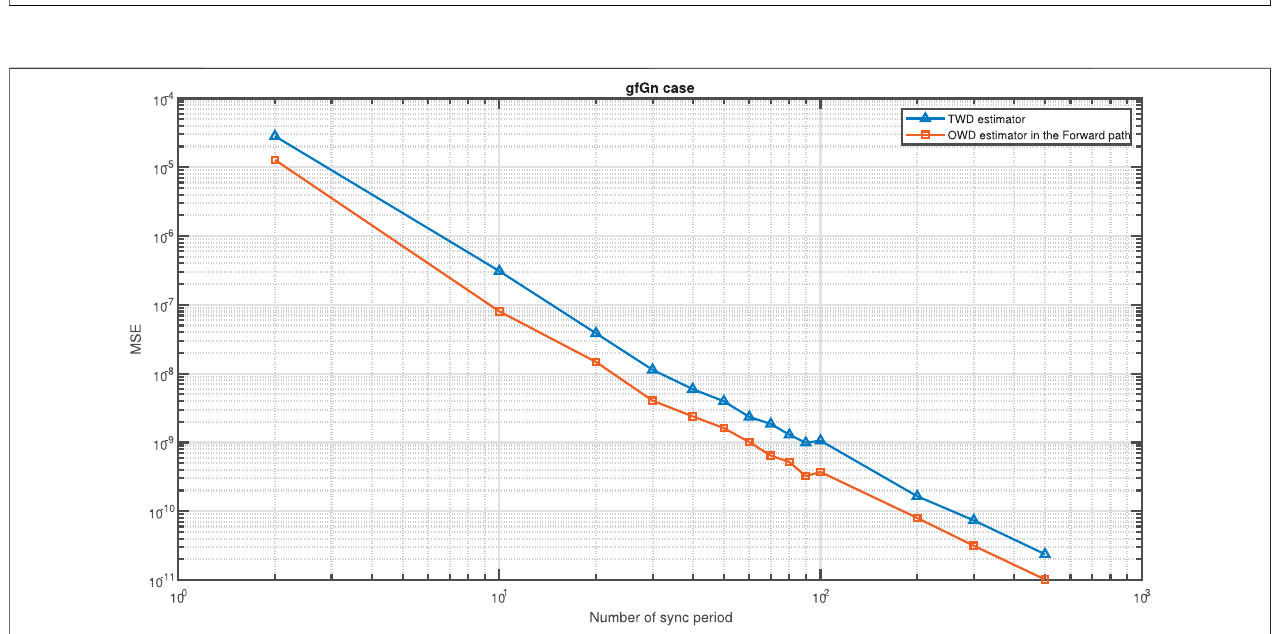
FIGURE 6 | Test case c of Theorem 8. Performance (MSE) comparison between the OWD clock skew estimator in the Reverse path ( Eq. 62 ) and the TWD clock skew estimator ( Eq. 60 ). The PDV is an fGn process. α = 50 ppm , Q = 5 ms , T syn (cid:2) 15 . 6 ms ( 64 packet 1, ~ σ 2 fGn / gfGn ( J (cid:2) 500 ) (cid:2) 1 . 03 e − 6 (for J < 500: ~ σ 2 fGn / gfGn > 1 . 03 e − 6, ~ σ 2 fGn / gfGn ( J (cid:2) 100 ) (cid:2) 3 e − 6, ~ σ 2 fGn / gfGn ( J (cid:2) 60 ) (cid:2) 4 . 3 e − 6, ~ σ 2 fGn / gfGn ( J (cid:2) 10 ) (cid:2) 1 . 72 e − 5). The results were obtained for 100 Monte-Carlo trails.